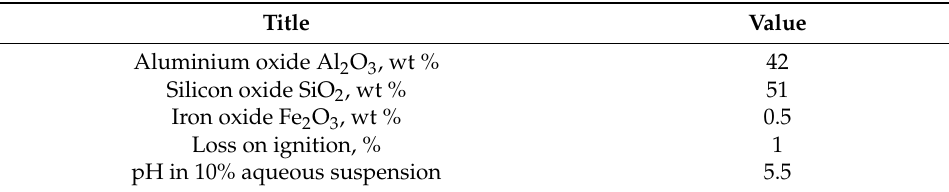
Table 2. Chemical composition of metakaolin RossPolymer “MetaKaolin 1400”.